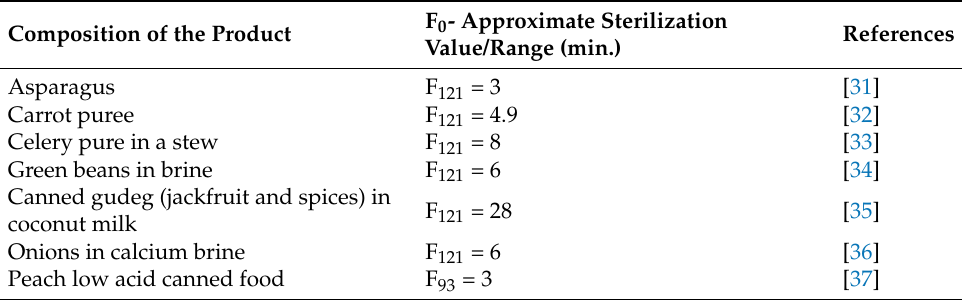
Table 2. Sterilization value or F 0 for vegetables and fruits. Composition of the Product